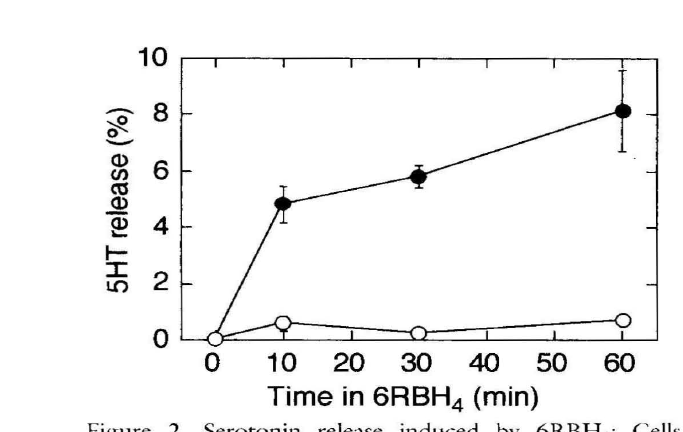
Figure 2. Serotonin release induced by 6RRH 4: Cells " 'ere exposed to 1 00 ~M 6RRH 4 and serotonin ac -:umulated in the medium was measured at indicated rimes (closed circle). Control experiment was performed